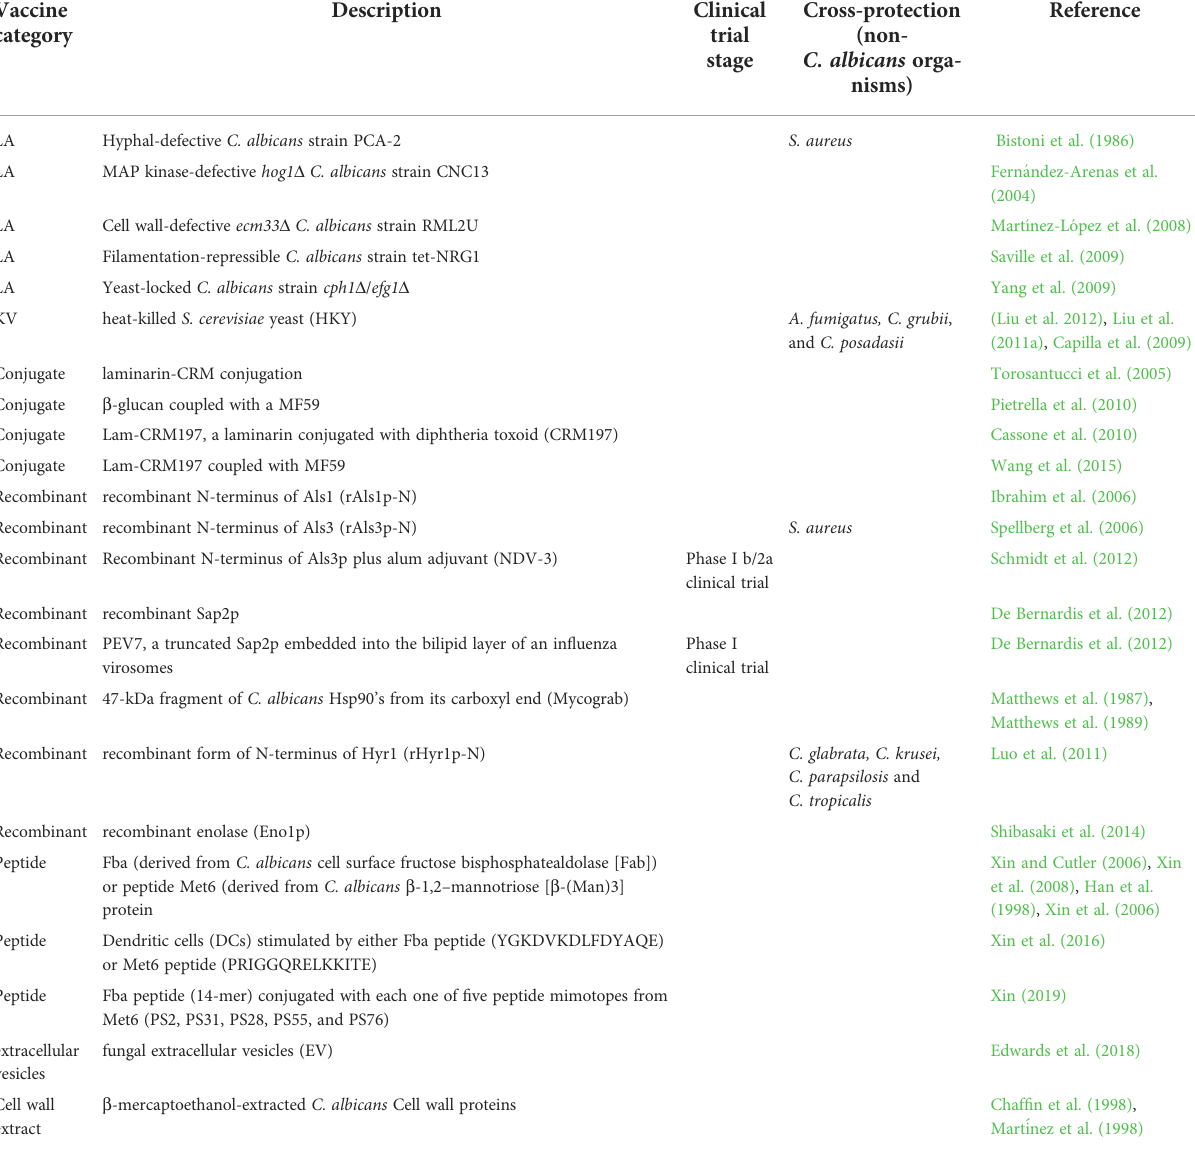
TABLE 1 Summary of experimental anti- Candida vaccine candidates. Vaccine